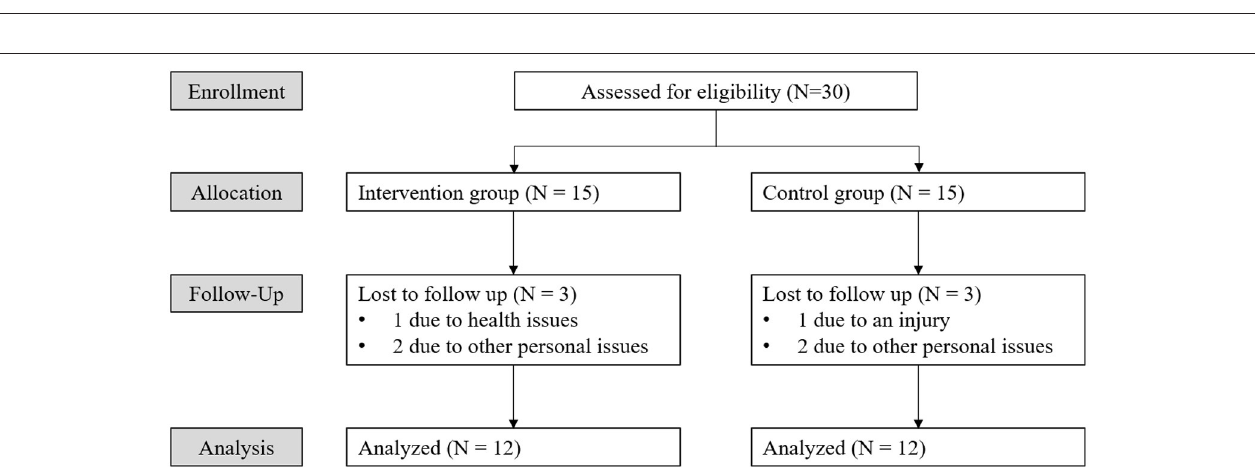
FIGURE 1 | Overall workflow of a novel Kinect-based tailored interactive fall intervention system.